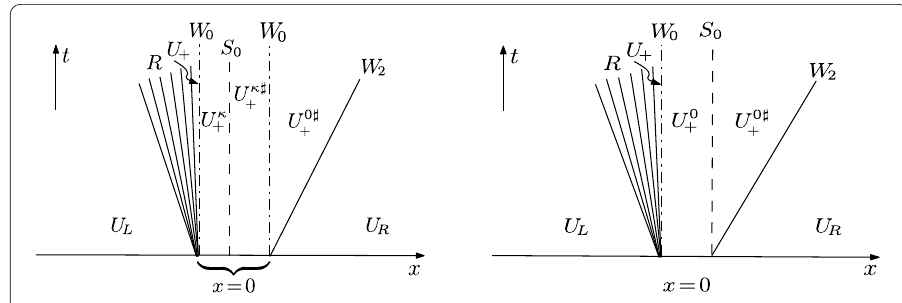
Figure 11 The Riemann solution at ( x , t ) space for subcases (B5)-(a) (left) and (B5)-(b) (right),